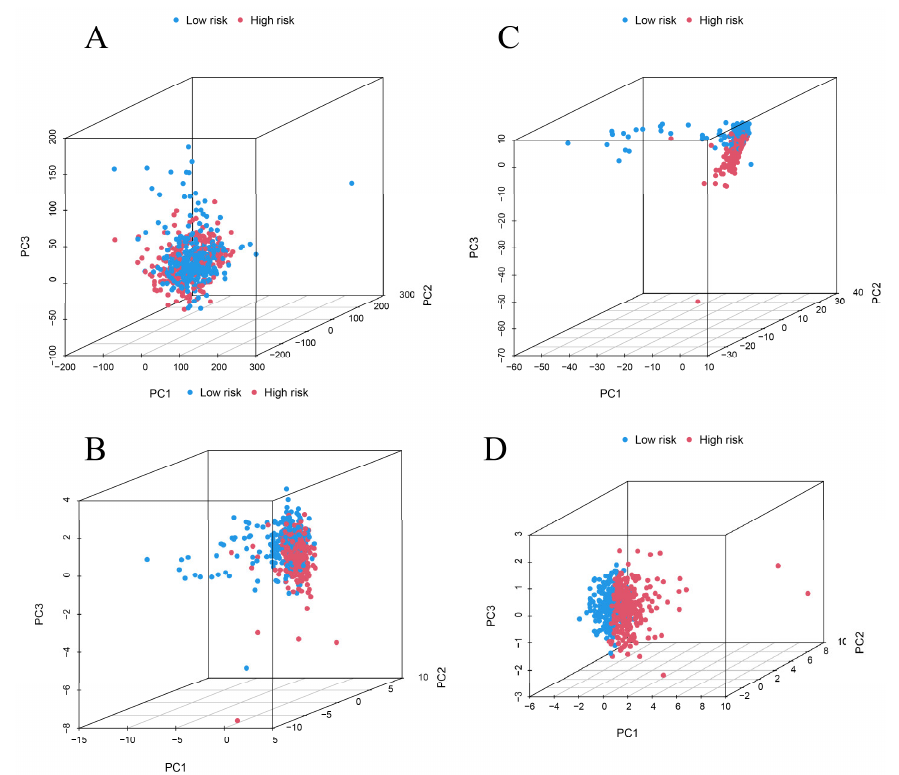
Figure 9. PCA analysis. ( A ) PCA of all genes. ( B ) PCA of 10 cuproptosis genes. ( C ) PCA of 280 CRLR genes. ( D ) PCA of three CRLRs.